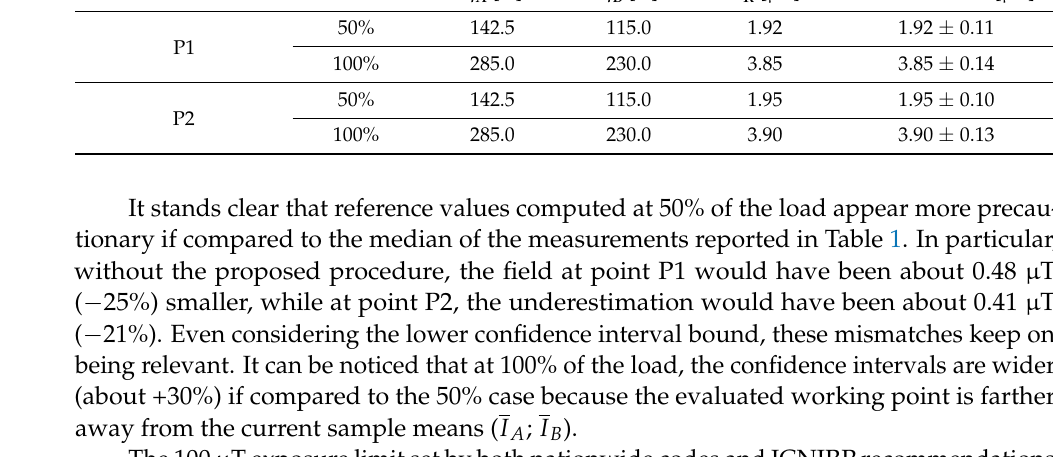
Figure 12. Positions P2 field ( left ) and its standard deviation ( right ) evolution (green trace) over the 24 h as a function of the currents in circuits A and B (i.e., (cid:1835) (cid:3002) and (cid:1835) (cid:3003) ). Current barycenter, and field evaluated at 50% and 100% of the line capacity are reported in all the frames. As anticipated, the method succeeds in providing field estimation for current refer- ence values (cid:1835) (cid:3045)(cid:3002) and (cid:1835) (cid:3045)(cid:3003) that might be noticeably different from the set of data used for the regression. Third-party low-frequency field sources did not introduce any appreciable detrimental effects on the procedure. Since Section 2 assumptions and simplifications hold, no spatial information or 3D FEM codes was used at any development point (differ- ently from the most state of the art). 5. Conclusions This work described a straightforward methodology explicitly developed for non- optimized double-circuit medium-voltage overhead power lines. Using the multiple lin- ear regression and the least mean squares techniques, it can estimate the proportionality coefficients between measured magnetic flux density and the line currents. The method